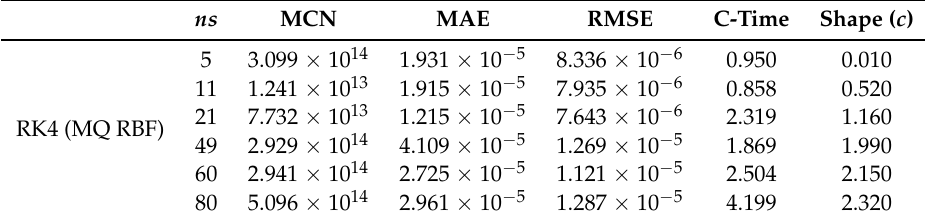
Table 1. Numerical results when N = 400 for domain [ 0,1 ] 2 (Example 1).